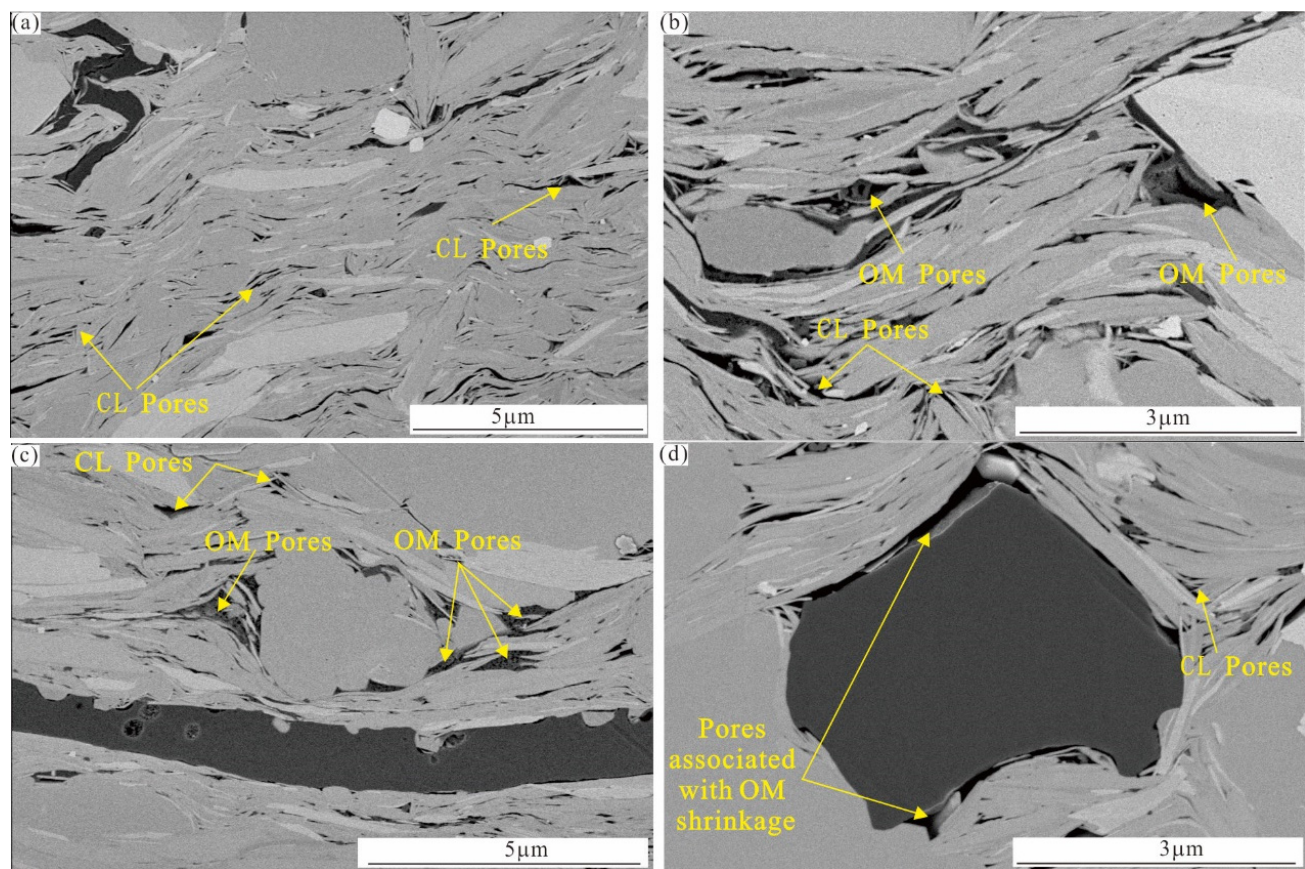
Figure 5. SEM images showing pore types of the Lower Jurassic Dongyuemiao lacustrine shale. ( a ) FY B well, gray argillaceous shale, TOC = 1.33%; ( b ) XL A well, gray argillaceous shale, TOC = 1.96%; ( c ) FY B well, gray argillaceous shale, TOC = 1.64%; ( d ) XL A well, gray argillaceous shale, TOC = 1.46%.